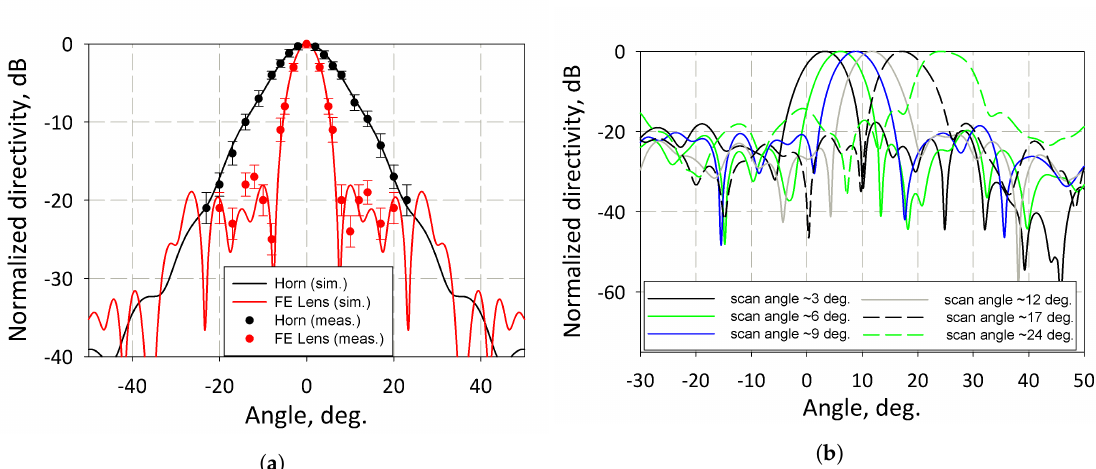
Figure 8. Comparison of the simulated and measured of ( a ) beam focusing, and simulation results of ( b ) the beam scanning